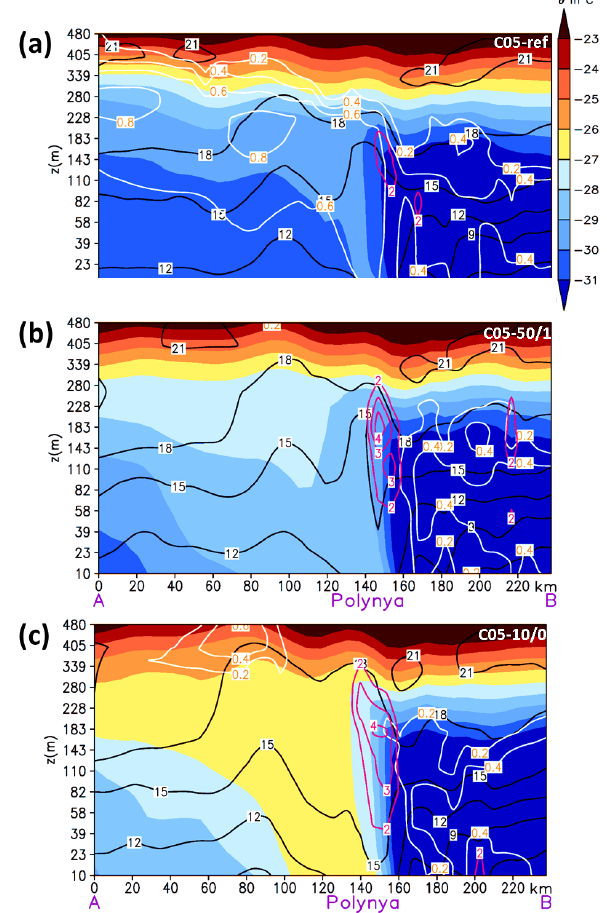
Figure 7. Vertical cross sections of the potential temperature (cid:50) , horizontal wind speed (black contour lines), turbulent kinetic en- ergy (TKE in m 2 s − 2 , magenta contour lines), and cloud frac- tion (white contour lines and orange labels) on 4 January 2008 at 15:00UTC for (a) C05-ref (reference), (b) C05-50/1 (realistic), and (c) C05-10/0 (open water). The horizontal distance is about 240km and the location of the cross section A (pack ice) → B (fast ice) is shown in Fig.